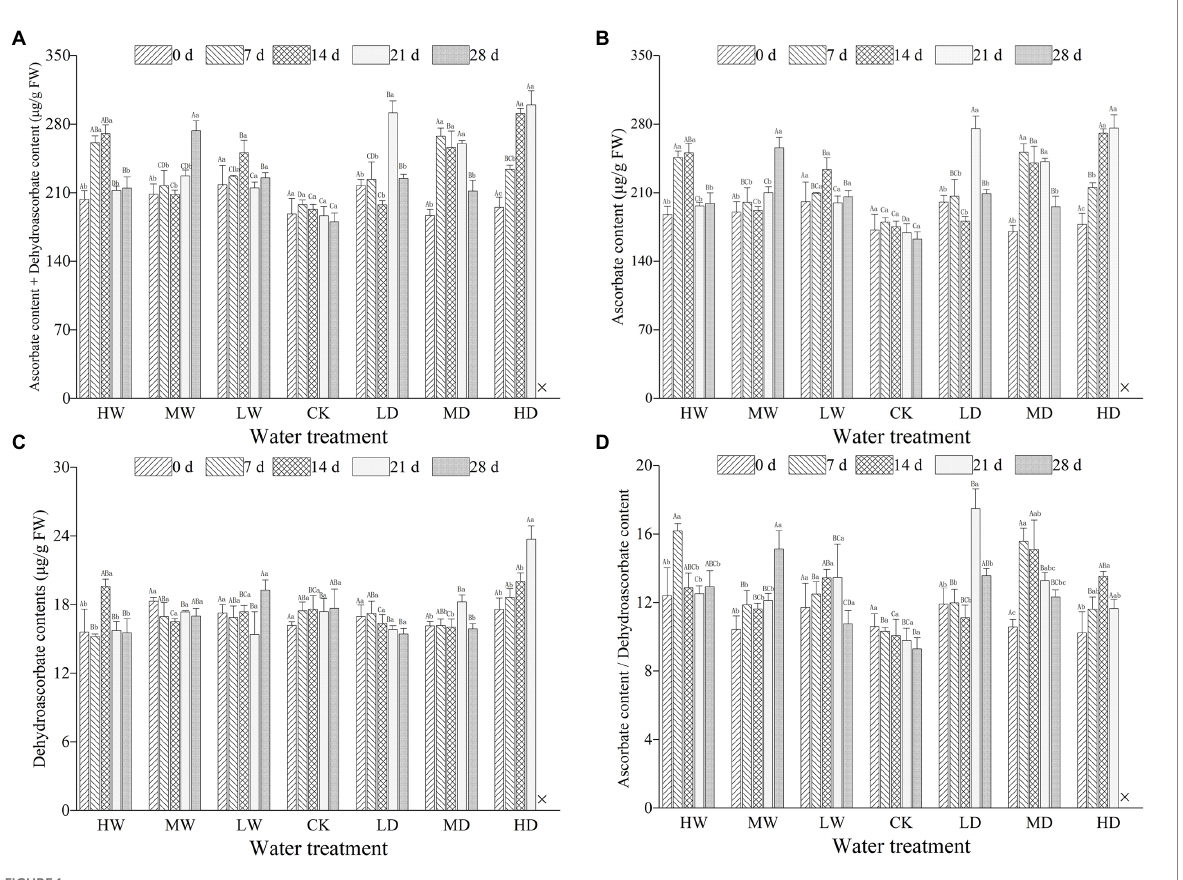
FIGURE 1 Total ascorbic acid content (A) , ascorbate content (B) , dehydroascorbate content (C) and ratio of ascorbate to dehydroascorbate (D) in leaves of hairgrass ( Deschampsia caespitosa ) under contrasting hydrological regimes and durations. Bar values are the mean ± standard error ( N = 3). Different lowercase letters indicate that there are significant differences among stress exposure durations under the same hydrological treatment; and different capital letters indicate that there are significant differences across different water hydrological regimes at the same exposure duration. X represents the plant died, and thus not allows this parameter to be determined unless stated otherwise. Water treatment are as follows: HW, Heavily waterlogging; MW, Moderate waterlogging; LW, Light waterlogging; CK, Control; LW, Light drought; MW, Moderate drought; and HW, Heavily